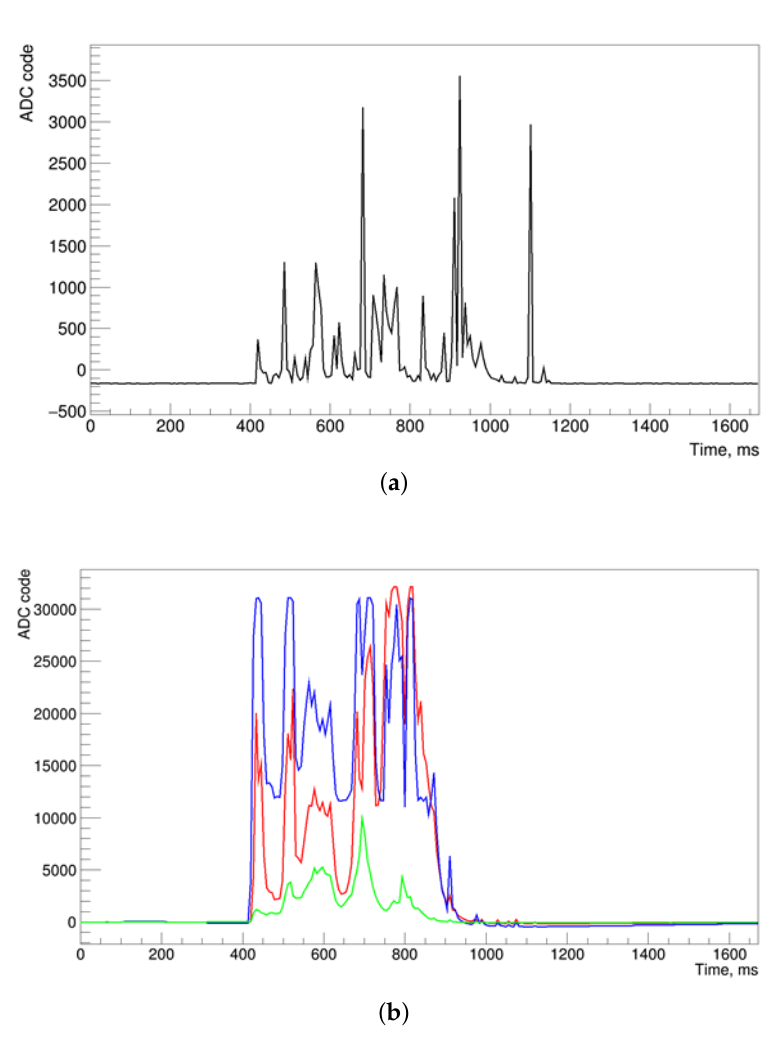
Figure 14. Waveforms of two events registered in the meteor mode: a series of UV flashes above a thunderstorm ( a ), a far-from-thunderstorm event ( b ), see the